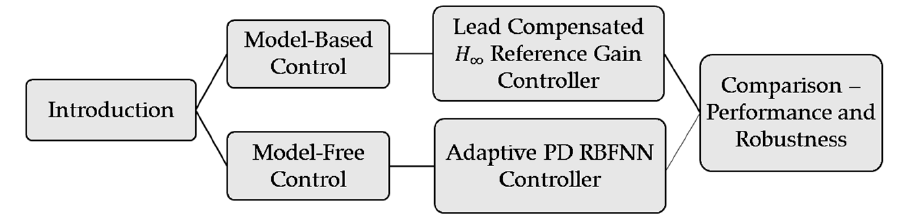
Figure 1. Research flow.